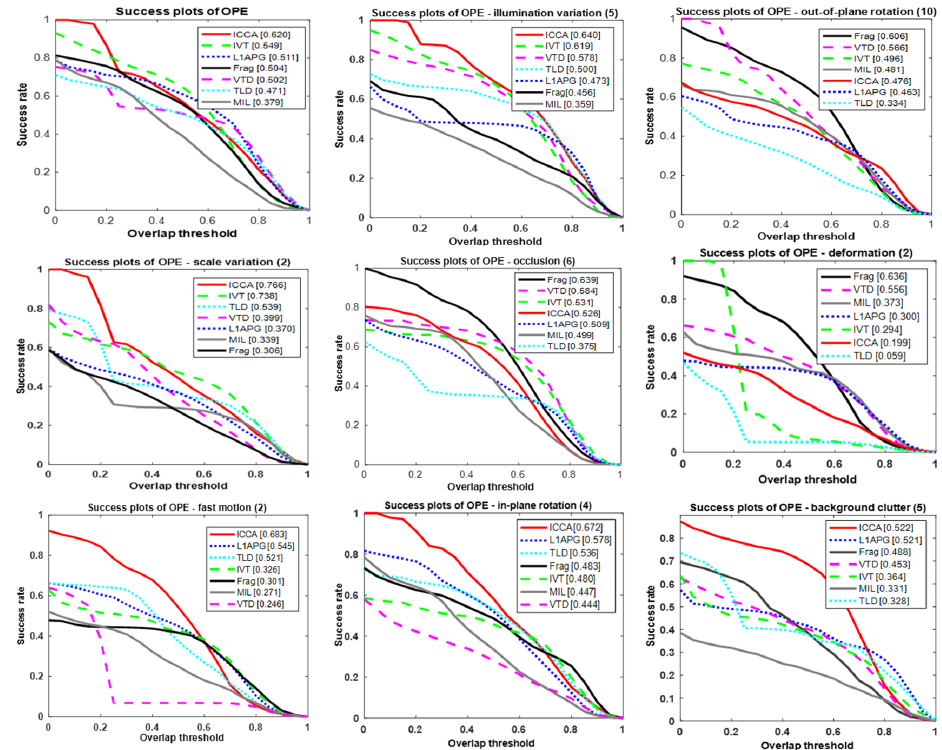
Figure 3 . Success rate of seven trackers on different attributes. Figure 3. Success rate of seven trackers on di ff erent attributes. Appl. Sci. 2020 , 10 , x FOR PEER REVIEW